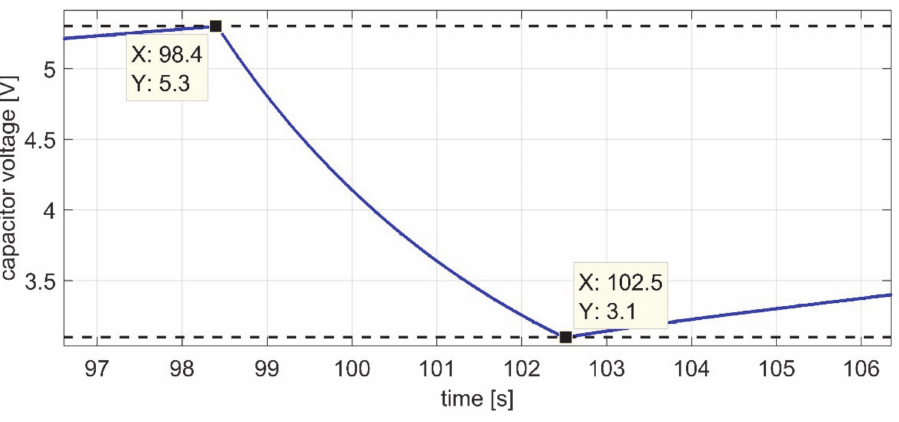
Figure 16. Discharging mode, d = 16 mm, and r = 3150